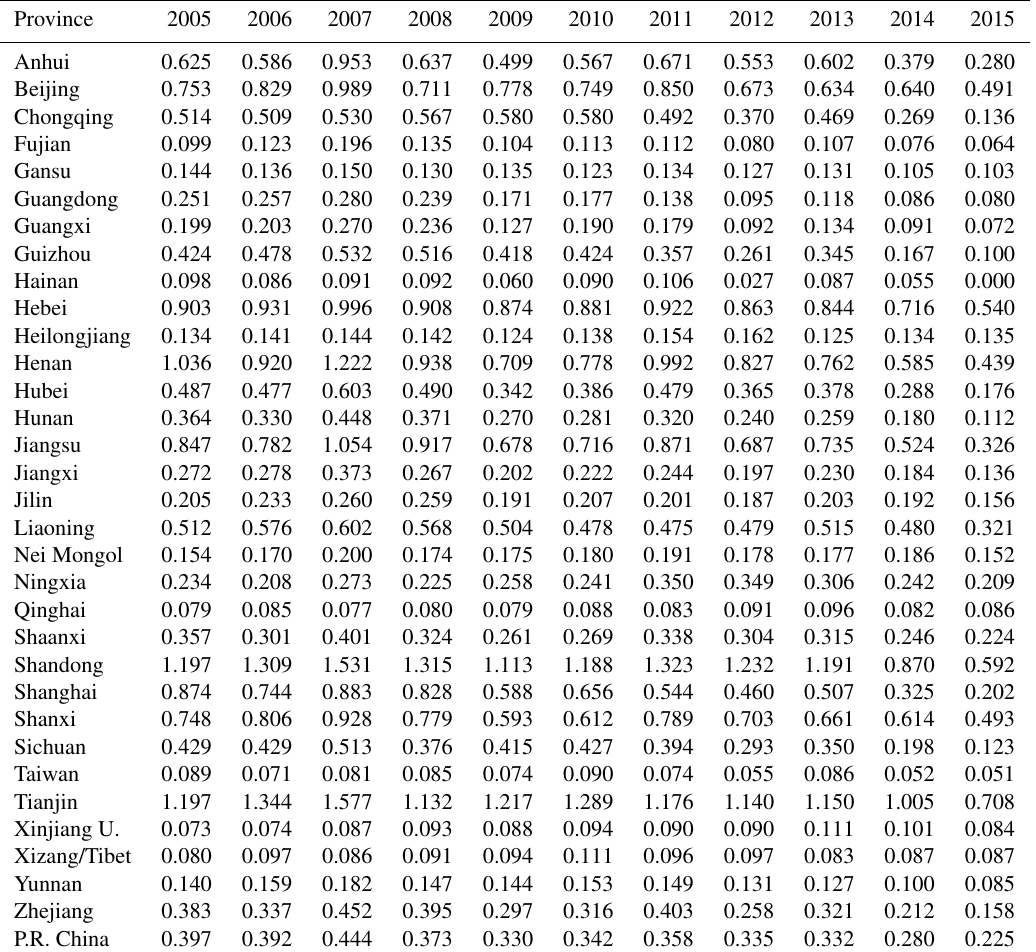
Table A1. Annual SO 2 column densities (DU/grid cell) per province observed by